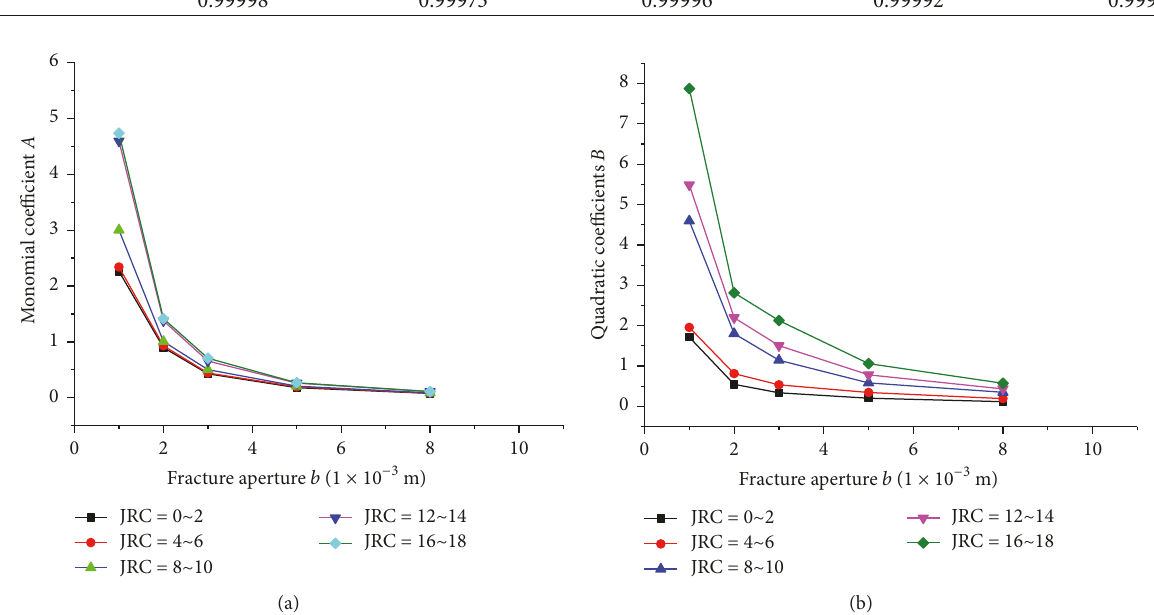
Figure 11: Relation between Forchheimer coefficient and fracture